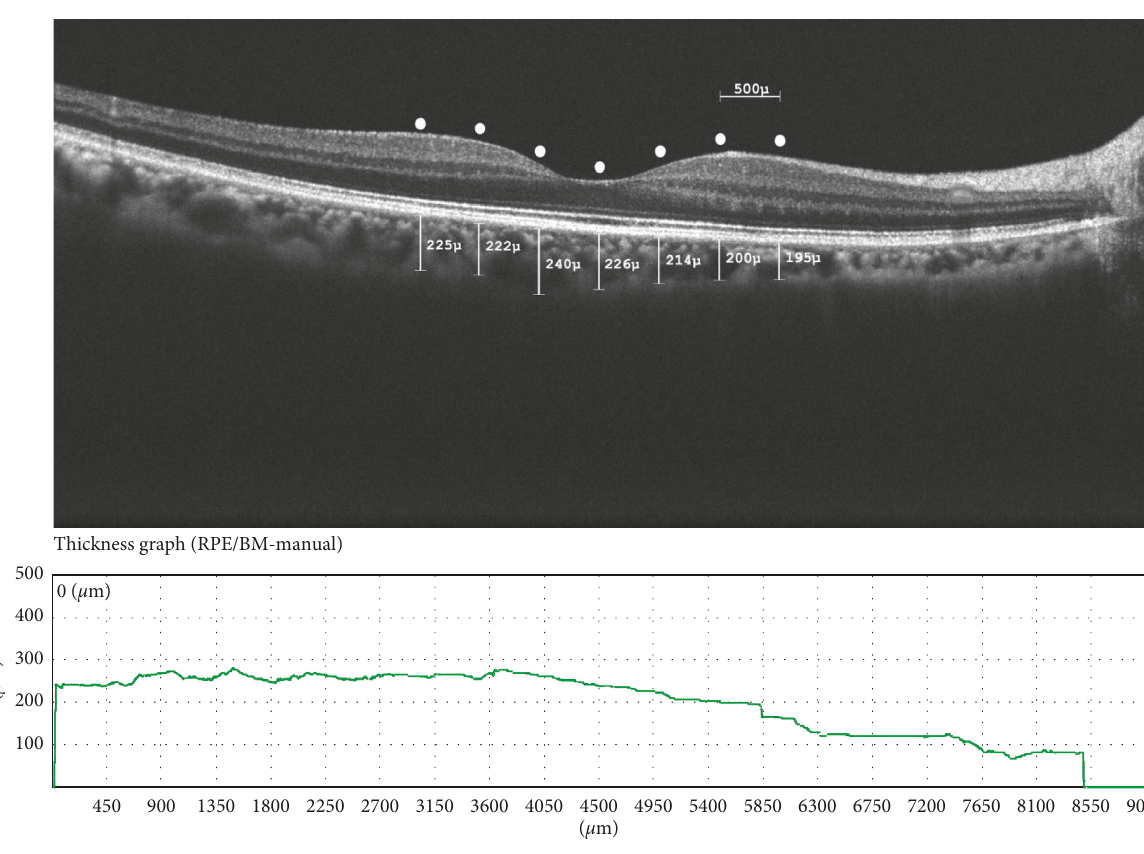
Figure 1: A represantative choroidal thickness in Graves’ ophthalmopathy. Table 2: Characteristics of patients in the study and control